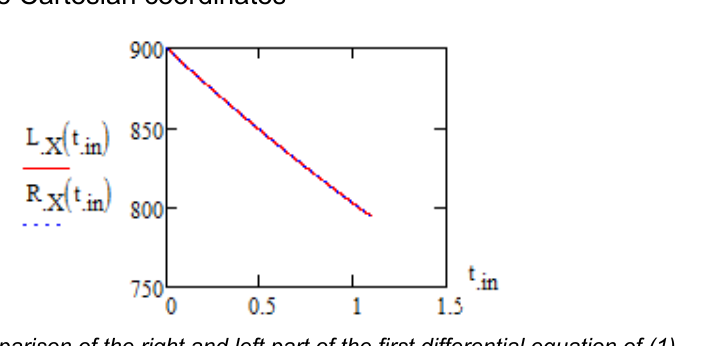
Figure 5 – Comparison of the right and left part of the first differential equation of (1) Рис . 5 – Сравнение правой и левой частей первого уравнения системы ОДУ